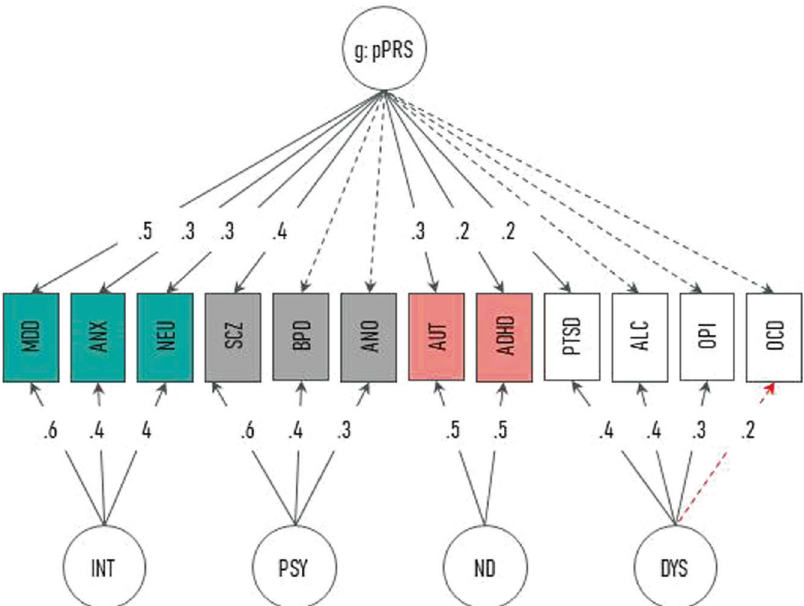
Fig. 2 Bifactor model omega with Schmid-Leiman transformation of the 12 genetic risk factors. Factor 1: “ INT ” = internalizing disorders; factor 2: “ PSY ” = psychotic disorders; factor 3: “ ND ” = neurodevelopmental disorders; factor 4: “ DYS ” = dysfunctional coping disorders; “ g ” : general pleiotropic pPRS factor. Dotted arrows = loadings < 0.20; black arrows = positive loadings; red arrow = negative